Question: Sum up the contents of this chart in one sentence.
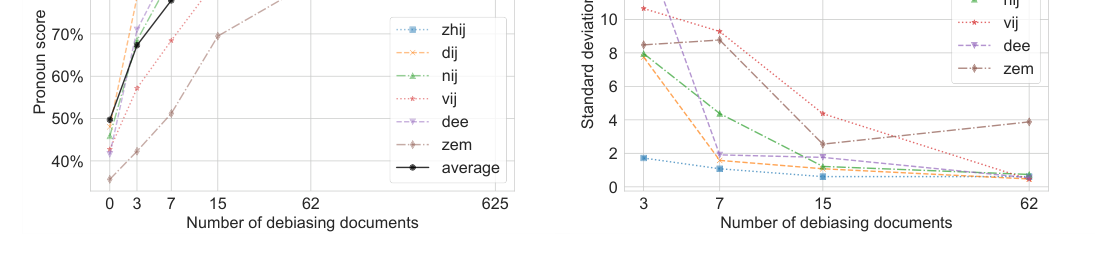
Answer: Neopronouns debiasing experiment: Pronoun scores across six neopronouns as a function of the number of debi- asing documents included in CDA continual fine-tuning. The black dotted line indicates the average pronoun scores across the different neopronouns. Reported scores are the average of five data partitions.